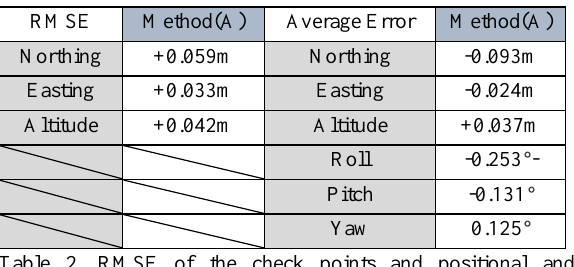
Table 2. RMSE of the check points and positional and orientational error of the images generated by Method(A).